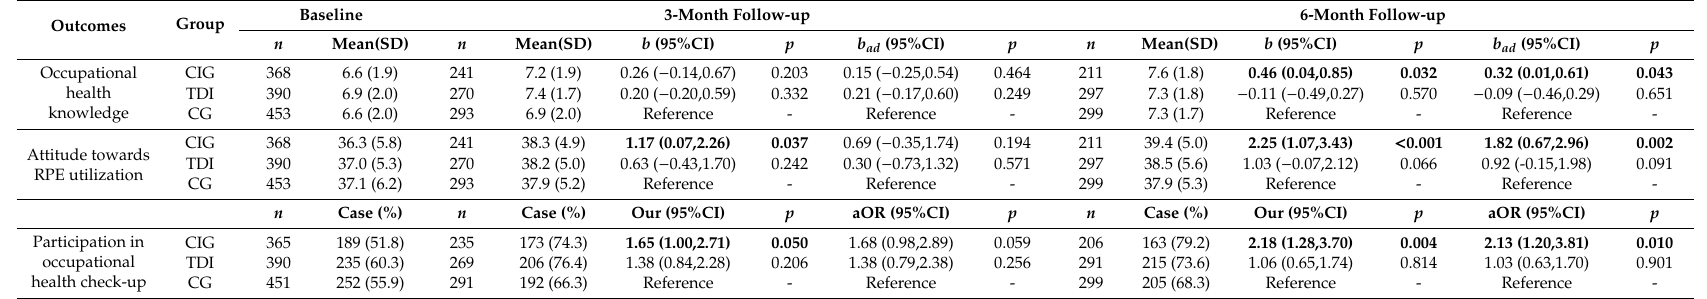
Table 4. Intervention e ff ectiveness on secondary outcomes at 3- and 6-month of intervention ( n =